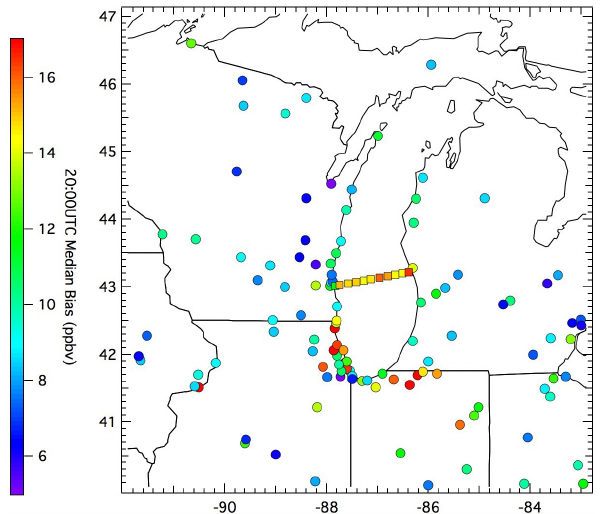
Figure 15. CMAQ model O 3 bias for air quality EPA station mon- itors (circles) and Lake Express ferry (boxes). EPA monitor biases are calculated at 20:00UTC (15:00CDT), and the data have been windowed for only those days when Lake Express ferry data are available. For the Lake Express ferry data are from the 12:30 to 15:00CDT transect